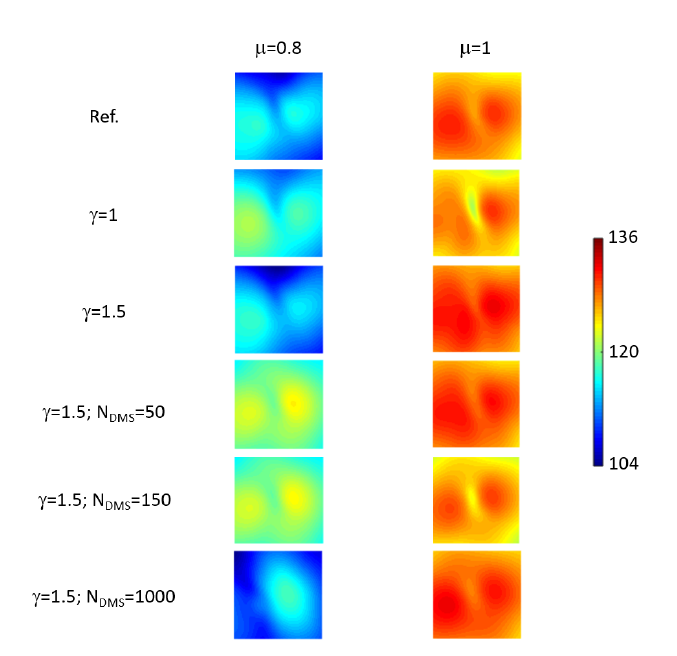
Figure 10. Acoustic patterns on the horizontal plane at the distance of 0.75 m in the direction Z for different C&B and DMS reductions, scale in dB.